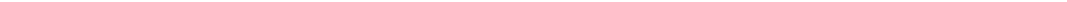
Figure 1: RheumaTool was validated at two time points: time point A, when only information from the first consultation was used, and time point B, when data from the additional diagnostic work-up were also considered. The correct diagnosis (reference diagnosis) was established either by disease criteria sets (DCS) or through the consensus of two independent, experienced rheumatologists. The output of RT was then compared to the reference diagnosis at both time points A and